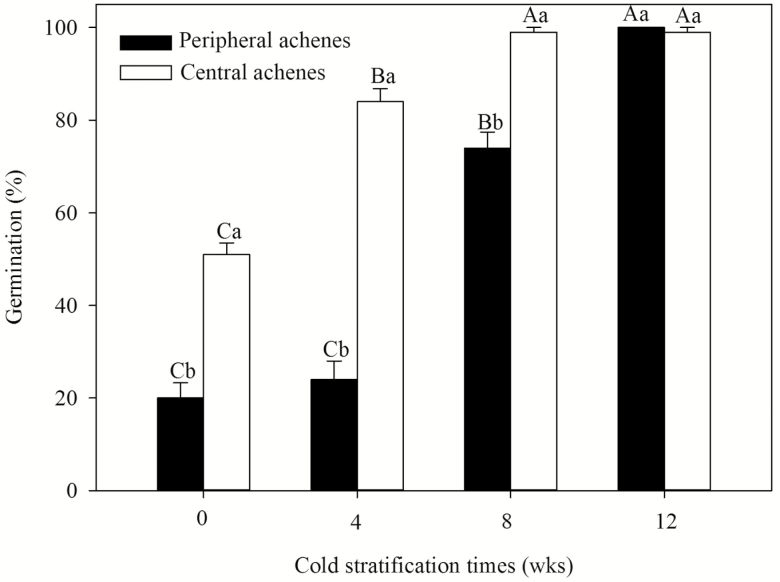
Germination percentages (mean ± SE) of central (white bars) and peripheral (black bars) achenes of Bidens pilosa at 25/15 °C after different weeks of cold stratification. The letters indicating significance are based on Tukey’s HSD after ANOVA. Different uppercase letters indicate significant differences among different cold stratification time and different lowercase letters indicate significant differences between central and peripheral achenes within each cold stratification time (5 % level).